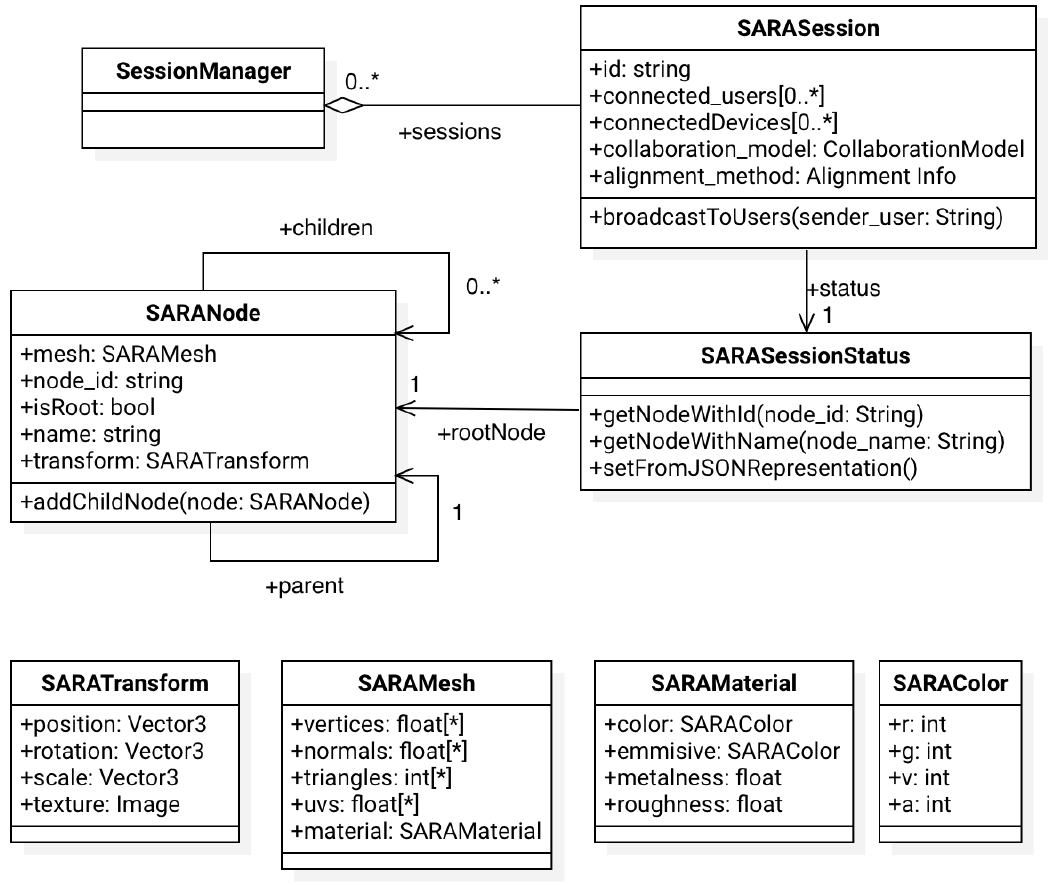
Figure 7. Class diagram of the most basic data model handled in the